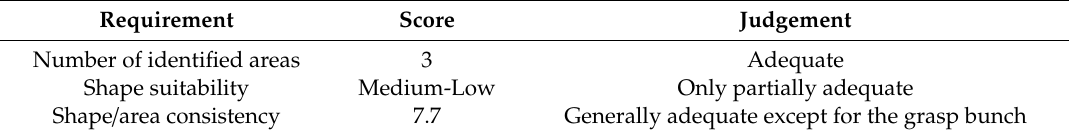
Table 5. Assessment of the criterion: subdivision by geographical